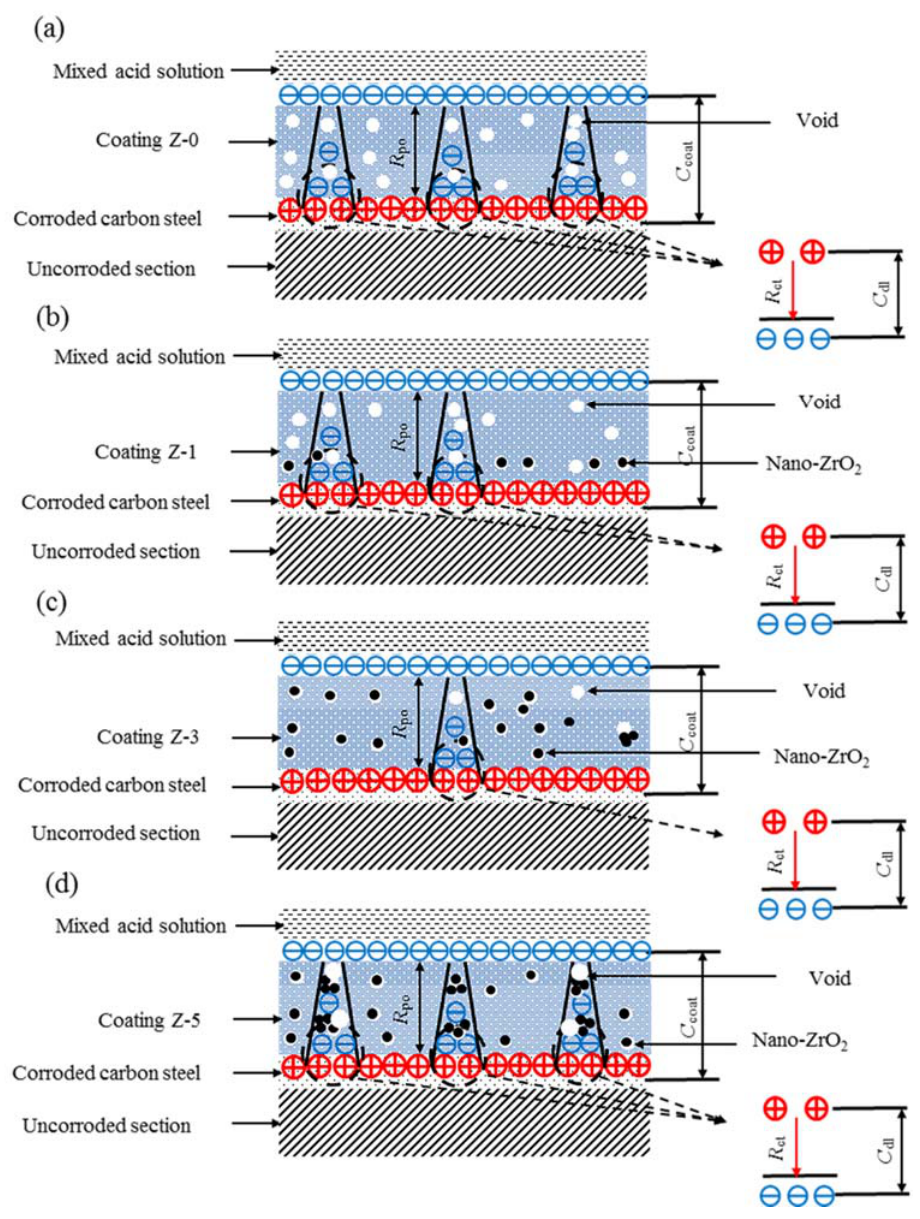
Figure 1 1 . Schematic illustrations of corrosion process for the Z ‐ 0 ( a ), Z ‐ 1 ( b ), Z ‐ 3 ( c ) and Z ‐ 5 ( d )